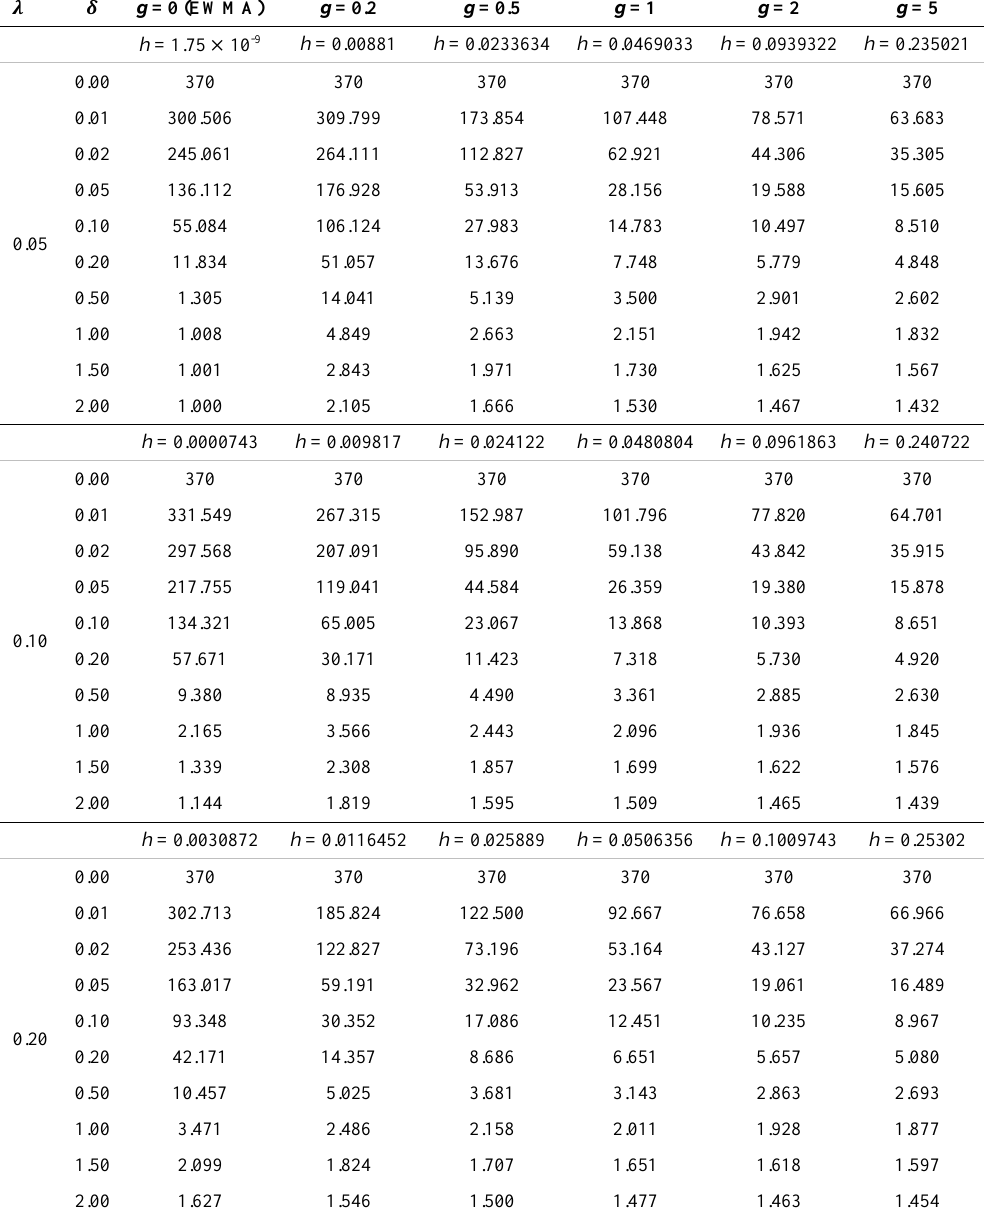
Table 6. Compare the modified EWMA charts on the IMA (2,1) model of the natural gas price at various λ and g